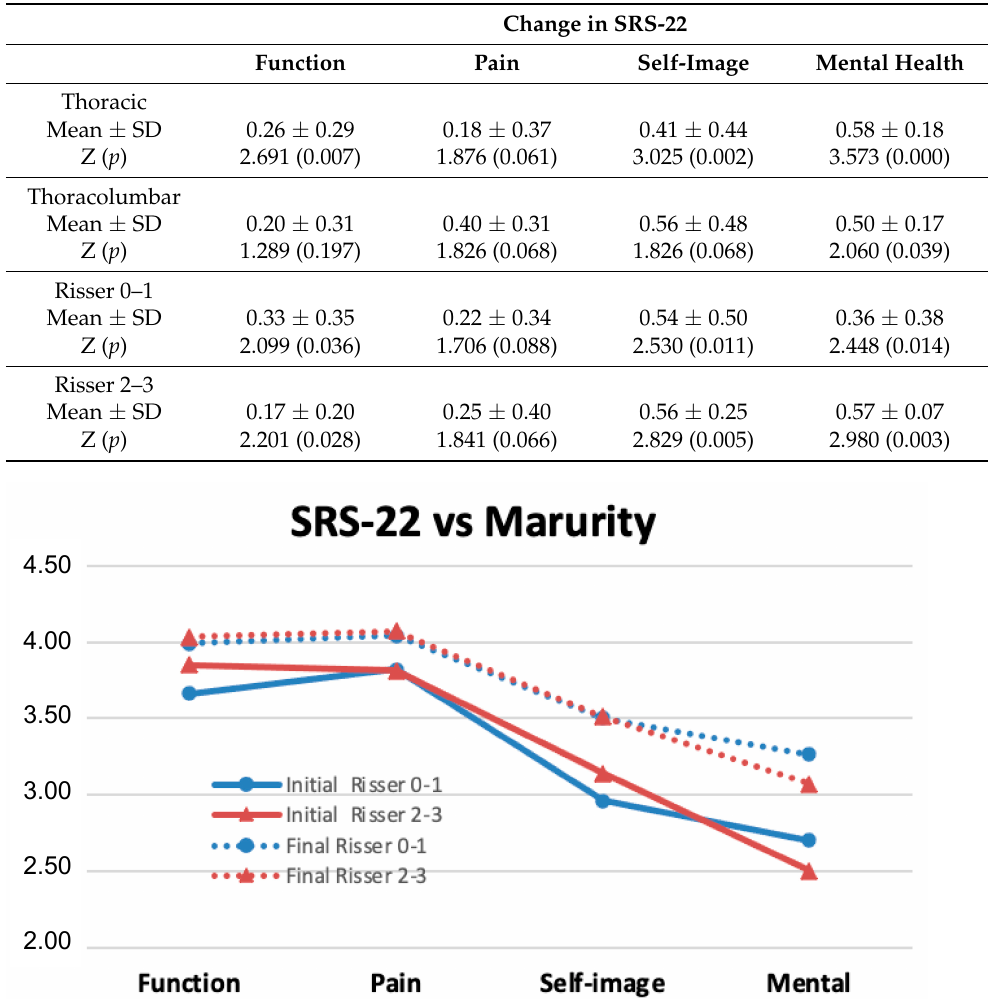
Figure 9. Results of the SRS-22 questionnaire according to curve location. Improvements were demonstrated in many of the tested domains. In most fields of the questionnaire, the thoracic curves improved further than the thoracolumbar curves. Table 5. Change in SRS-22 according to the deformity location and skeletal maturity.